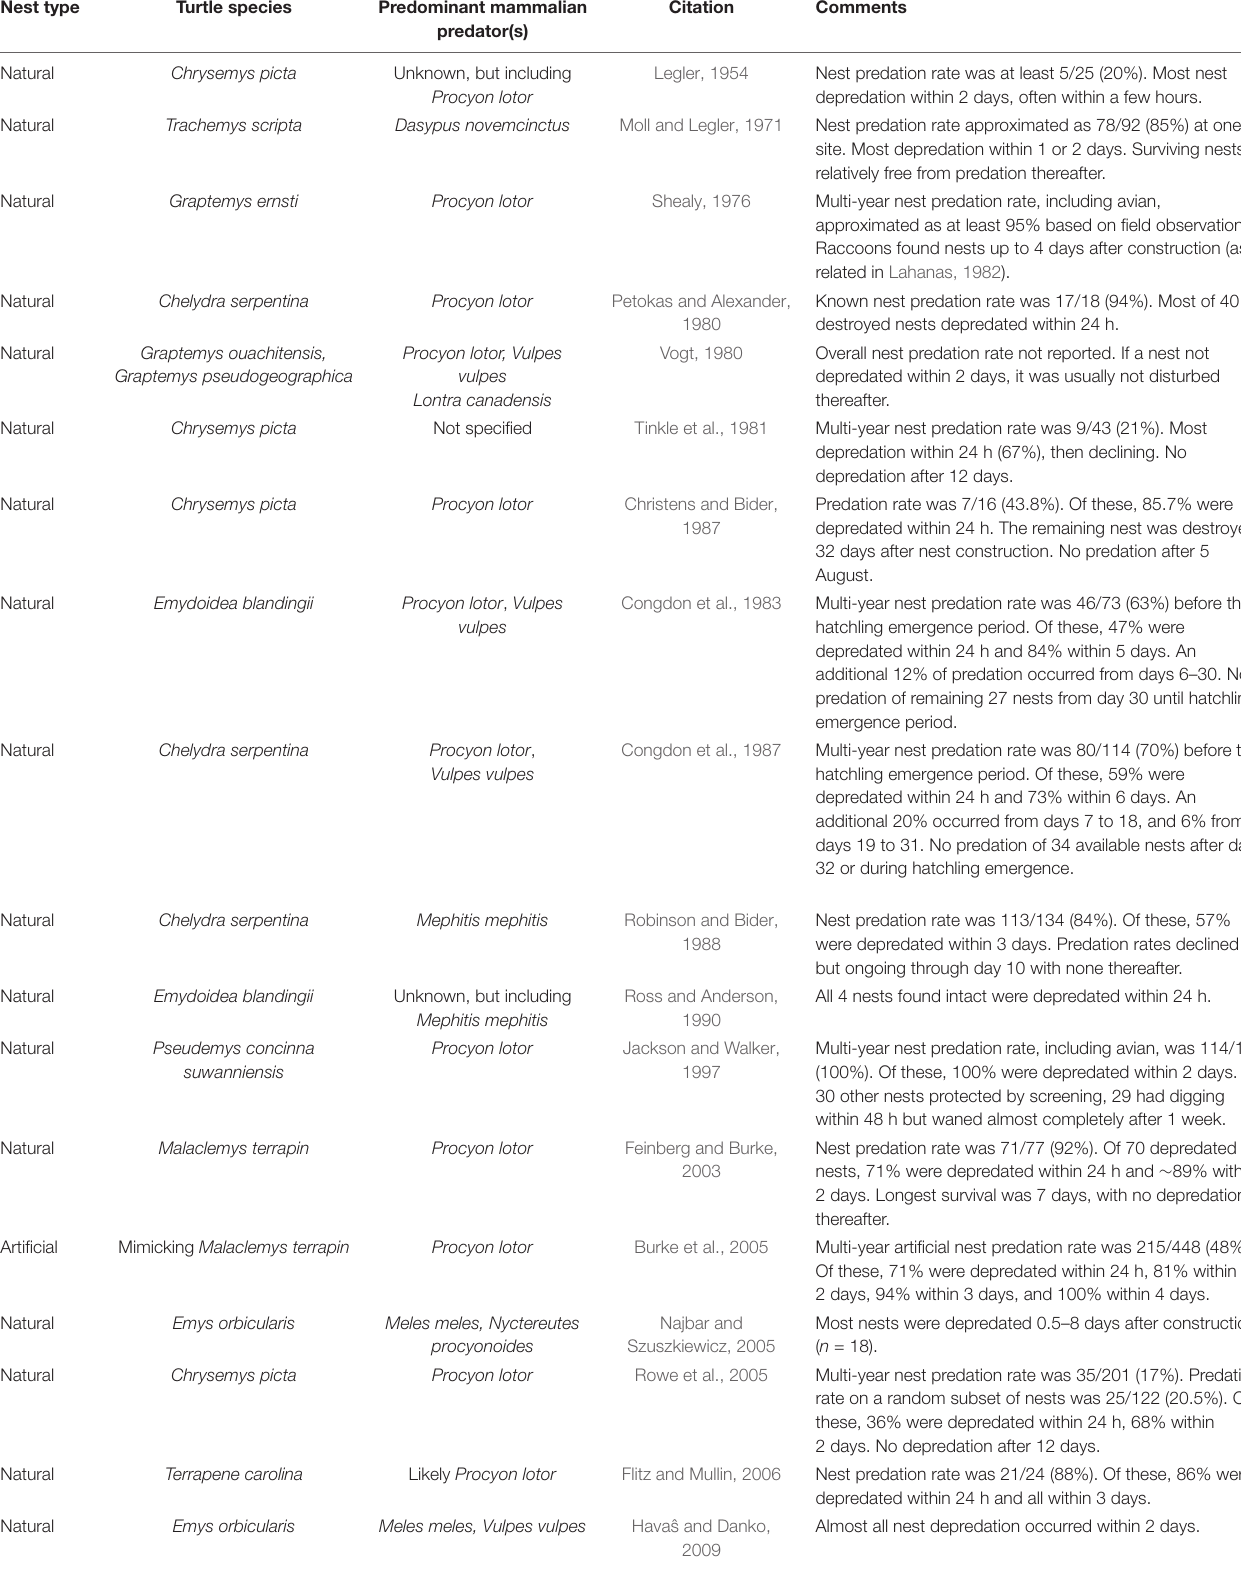
TABLE 4 | Papers proposing signal strength of cues used by mammalian predators to locate freshwater turtle nests decreases soon after nest